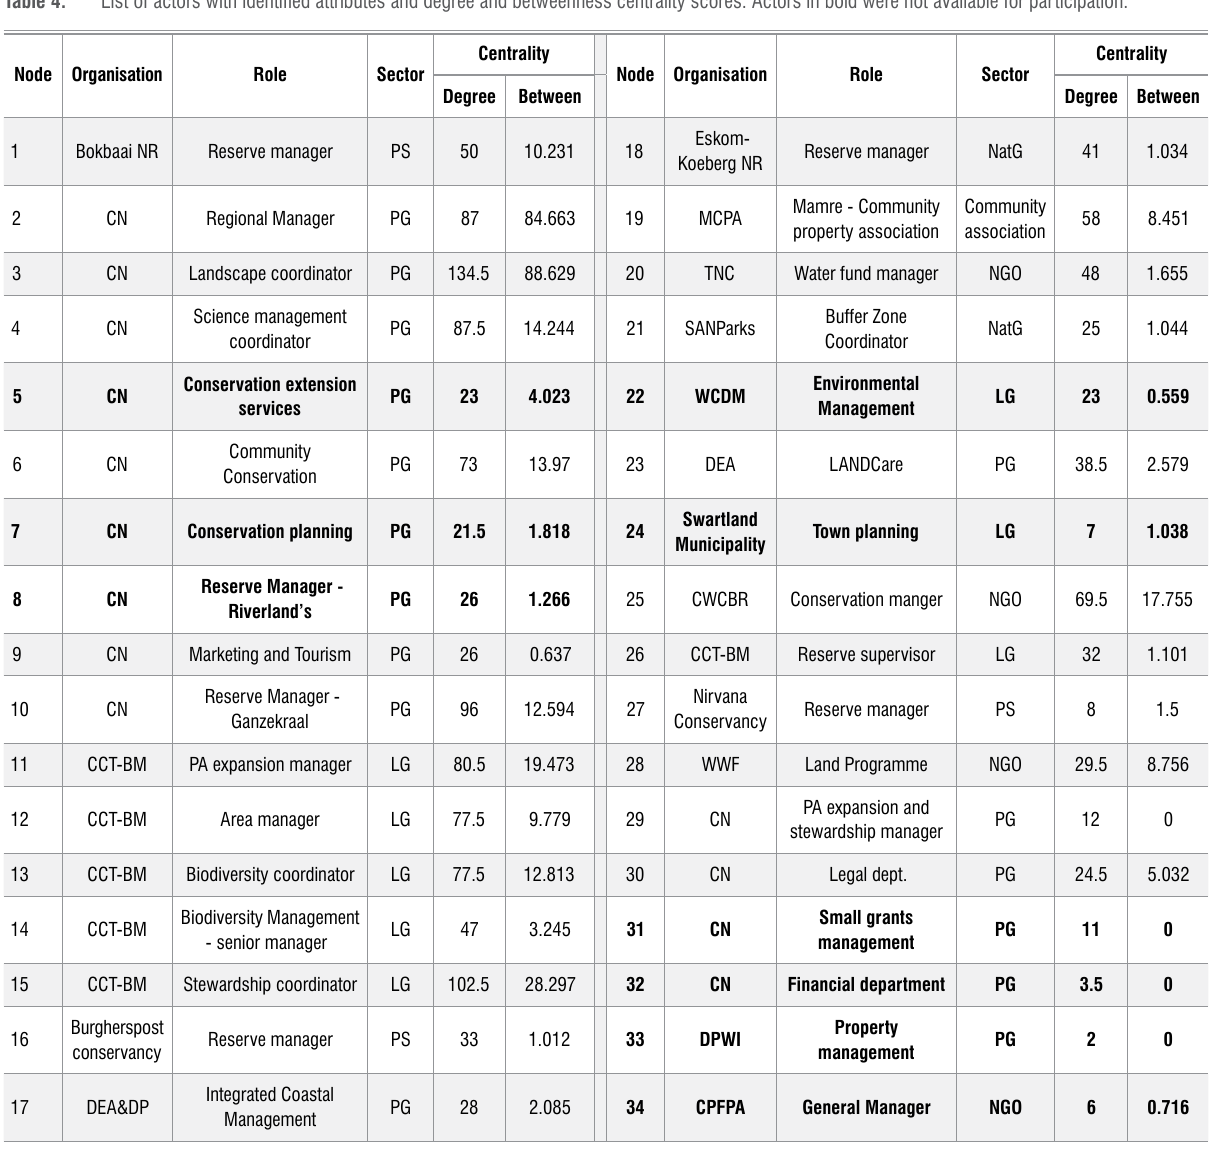
Table 4: List of actors with identified attributes and degree and betweenness centrality scores. Actors in bold were not available for participation.